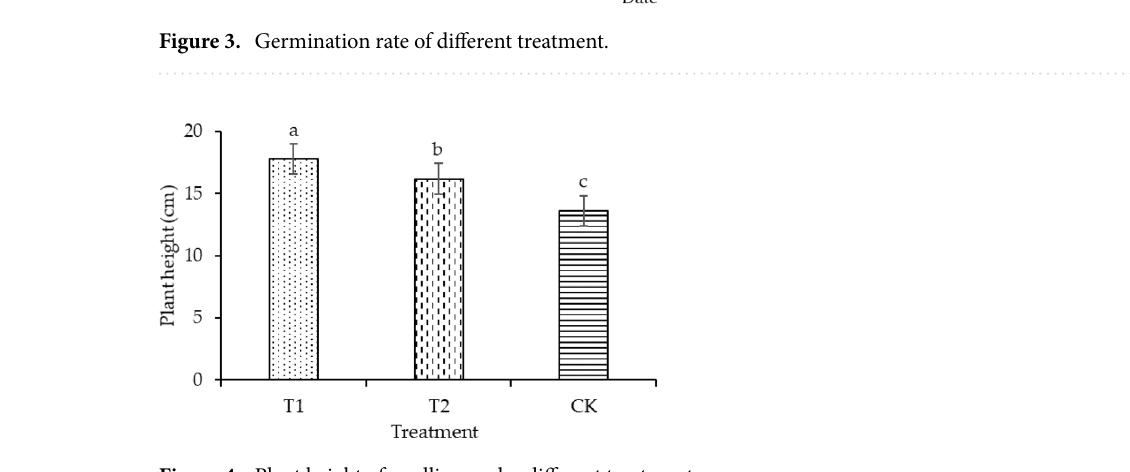
Figure 4. Plant height of seedling under different treatments.